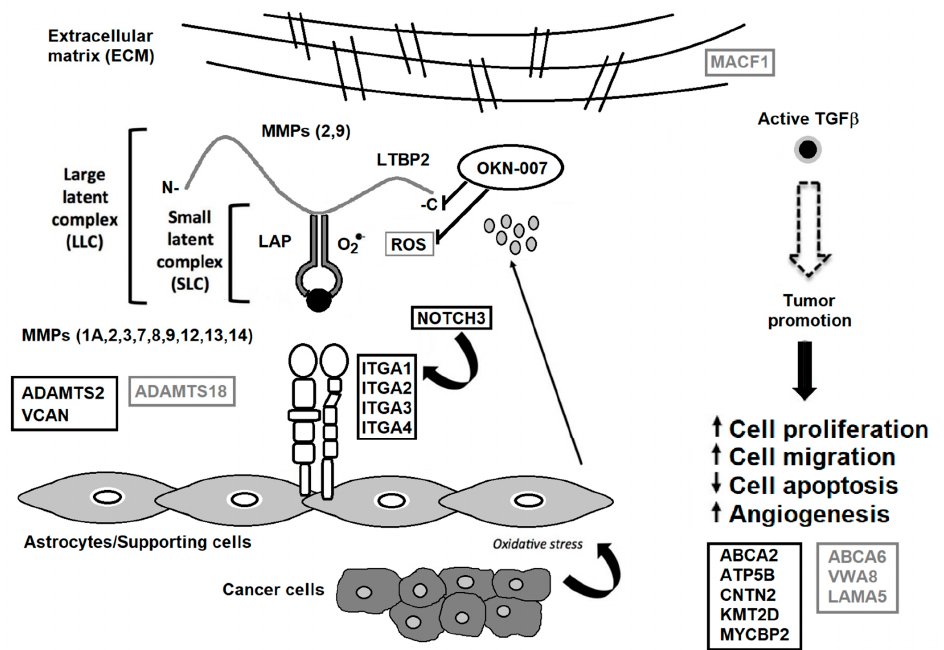
Figure 3. TGF- β associated with the tumor microenvironment. Some matrix metalloproteinases (MMPs) cleave LTBP, which releases latent TGF- β from the extracellular matrix (ECM). Various MMPs activate latent TGF- β through proteolytic cleavage of the latency-associated peptide (LAP), whereas integrins expressed on astrocytes (ITGA1, 2, 3 and 4) bind to the large latent complex (LLC), and activate latent TGF- β through MMP-dependent cleavage of LAP. Integrins (ITGA1, 2, 3 and 4) bind to the LLC and induce conformational changes in the latent complex through contractile action from activated astrocytes. Reactive oxygen species (ROS) produced by activated astrocytes from the induction of oxidative stress from nearby cancer cells may lead to the oxidation of the LAP domain and induce allosteric changes that release mature TGF- β from LAP. The mature (active) form of TGF- β can then bind to its receptor and then turn on tumor-promoting and tumor-suppressive properties. NOTCH3 activates ITGA1 [25], which are both decreased by OKN-007. VCAN is highly expressed in high-grade gliomas [37], which is decreased by OKN-007. ADAMTS2 is highly expressed in some cancers [28], which is decreased by OKN-007. ADAMTS18 is a tumor suppressor [40], which is elevated by OKN-007. During tumor promotion, activated TGF- β led to decreased apoptosis and increased cell proliferation, cell migration, and angiogenesis [45]. OKN-007 is thought to act via LTBP and downregulates several genes associated with the ECM [6], and is also a free radical scavenger [4], resulting in the reversal of the major tumorigenic characteristics, i.e., increases tumor cell apoptosis and decreases cell proliferation, migration and vascular angiogenesis [46]. Other proteins decreased by OKN-007 include ABCA2, ATP5B, CNTN2, KMT2D, and MYCBP2. Other proteins elevated by OKN-007 include ABCA6, VWA8, LAMA5, and MACF1. Serum proteins decreased by OKN-007 are highlighted in black rectangular boxes. Serum proteins elevated by OKN-007 are depicted in gray rectangular boxes. Previous down-regulated genes include ITGA1 , and 4 , ADAMTS2 , MMP 3, and 12 , as well as several collagen genes ( COL1A1 , COL3A1 , COL4A1 , COL5A1 , COL6A2, and COL7A1 ) [6]. Modified from Towner et al. [6] and Costanza et al.